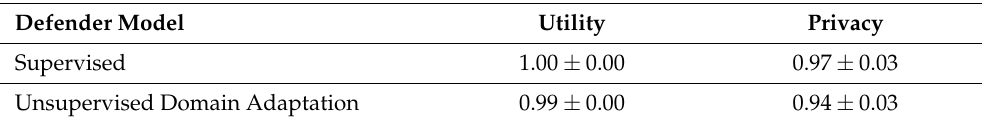
Table 2. Utility and privacy of DNN ResNet50 Defender models trained on